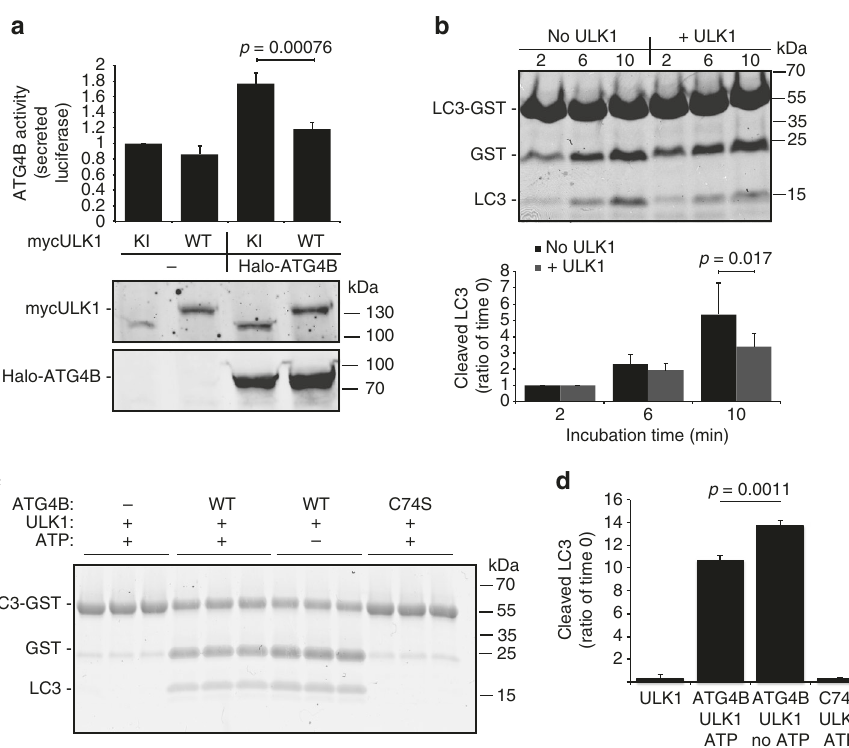
Fig. 1 ULK1 inhibits ATG4B-mediated LC3 cleavage. a Average ATG4B activity in Actin-LC3-DelN Luciferase HEK293T obtained by measuring the secreted luciferase activity 48 h after transfection with the indicated constructs ( n = 3, average ± s.d.) and representative immunoblot from one experiment showing expression of the different constructs. b GST-LC3 assay to measure in vitro activity of recombinant ATG4B after incubation with active recombinant ULK1. Representative gel and quanti fi cation of free cleaved LC3 ( n = 3, average ± s.d.). c GST-LC3 assay to measure in vitro activity of recombinant ATG4B after incubation with active recombinant ULK1 in the presence or absence of 1 mM ATP. Representative gel showing three independent replicates for each condition and d quanti fi cation of free cleaved LC3 ( n = 3, average ±